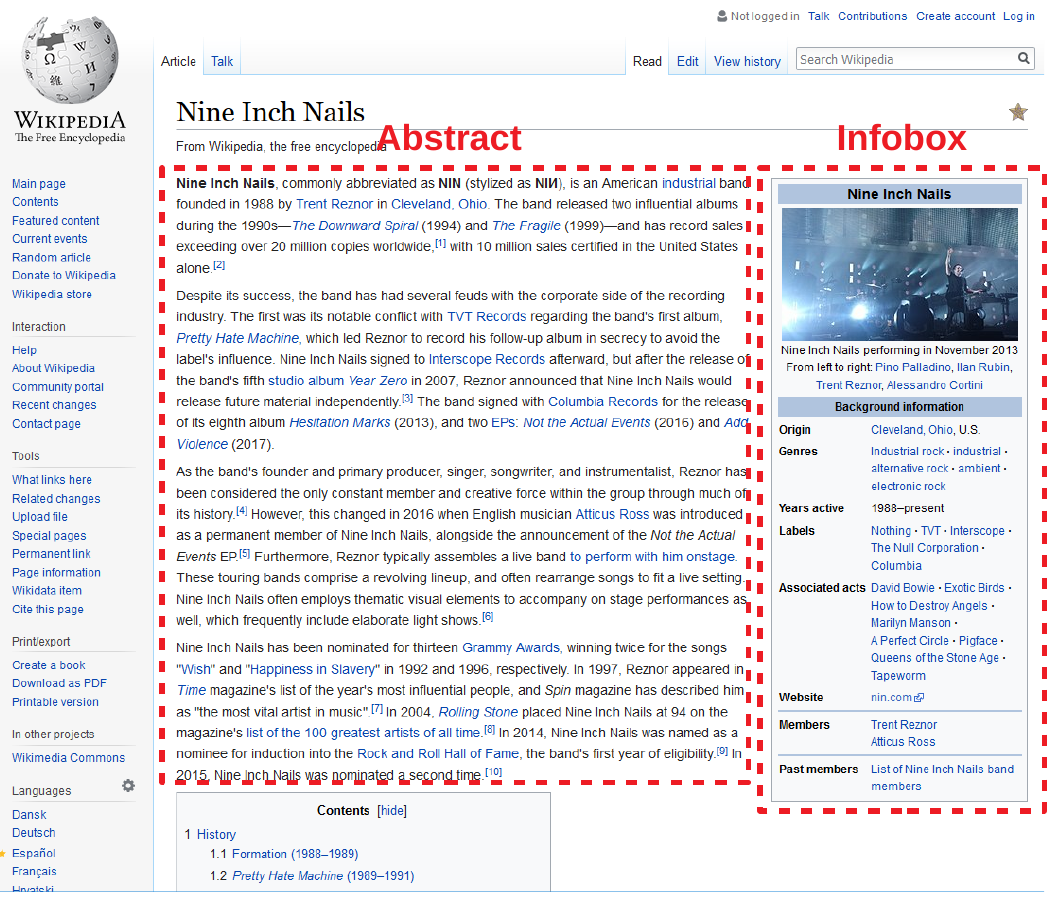
Figure 1. An example Wikipedia page. As the abstract, we consider the beginning of a Web page before the first structuring element (here: the table of